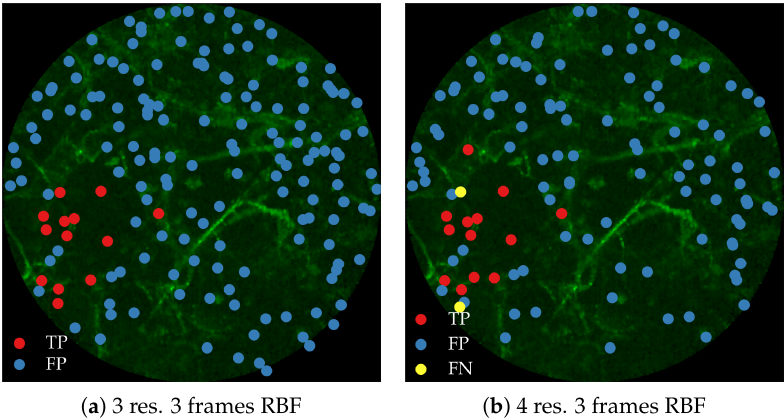
Figure 12. Ground truth annotations and detected cells at threshold